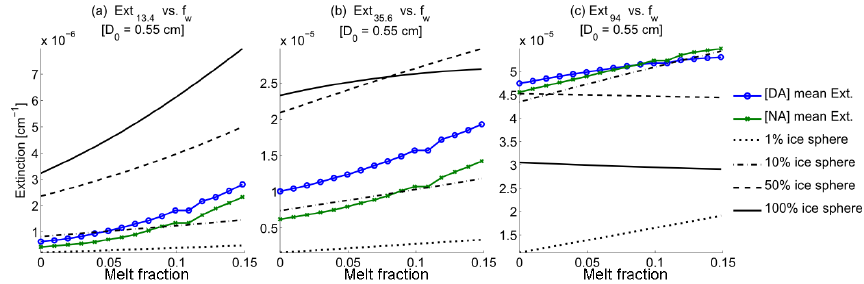
Figure 14. Same as Fig. 13 except for D 0 = 0 . 55cm. Note the different scaling on the vertical axes, including the exponents; the results in this figure may be subject to large particle diameter truncation, as discussed in the text.